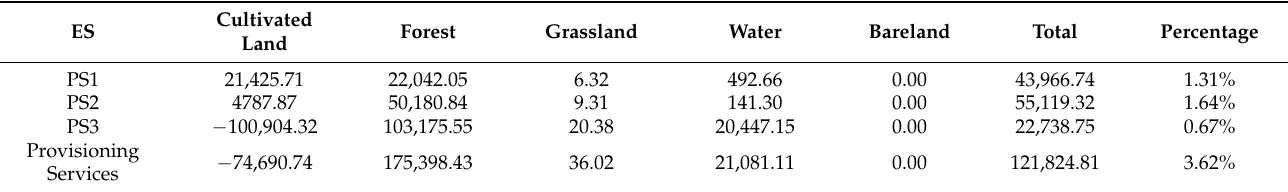
Table 6. Value of each ecological service in Ruijin City in 2020 (unit: ten thousand Yuan). Cultivated ES Forest Land